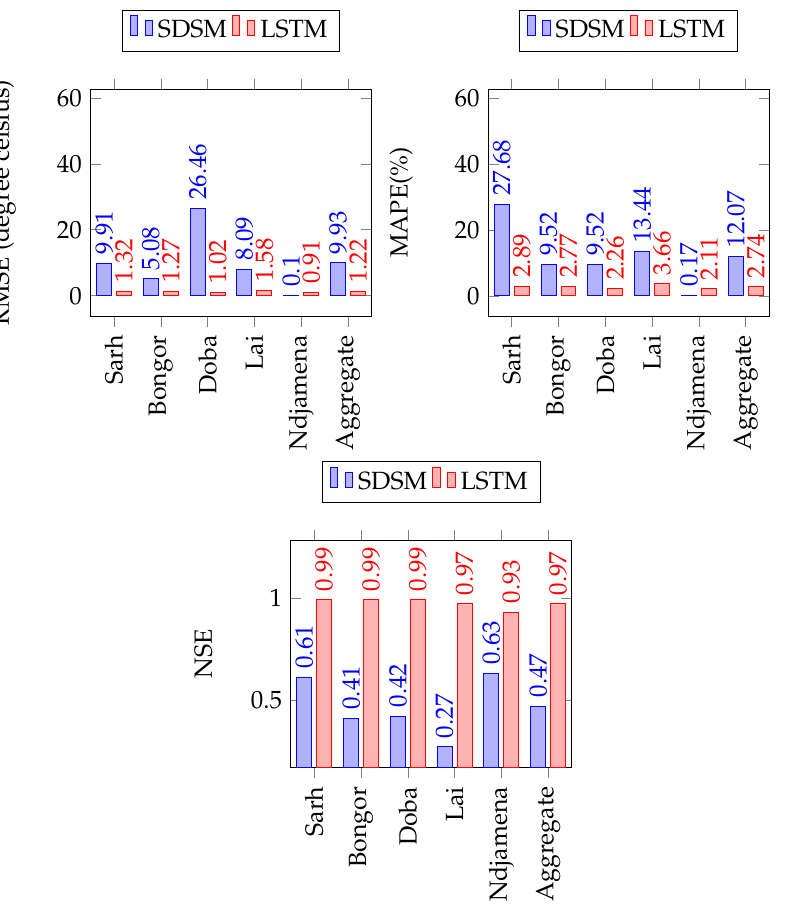
Figure 17. SDSM and LSTM forecasting performance comparison for monthly maximum tempera- ture